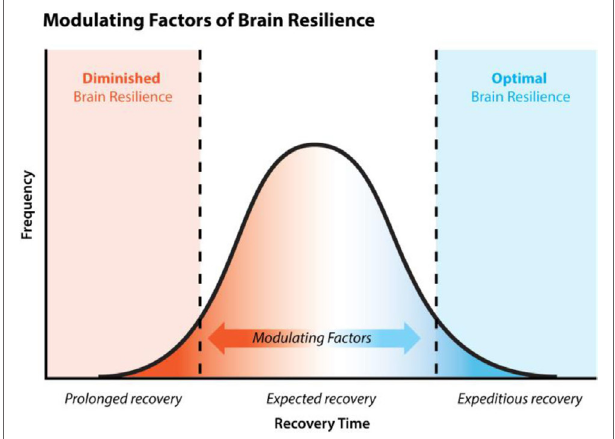
FiGURe 2 | Brain resilience and recovery time. Normal clinical recovery of concussion is expected within 7–14 days, post-injury. 10–15% of concussed individuals experience persistent symptoms, known as post-concussion syndrome, lasting > 3 months. Statistics are lacking regarding the percentage of concussed individuals who experience extremely fast resolution of symptoms 1–7 days. Brain resilience is a concept that considers various physiological states such as nutritional deficiency and the individual’s ability to detoxify toxic by-products like lipopolysaccharide, etc., and their impact on (a) the functioning of various mechanisms of recovery, (b) the speed of recovery, and (c) the efficacy of recovery. These various physiological states impact one’s brain resilience and therefore act as modulating factors to